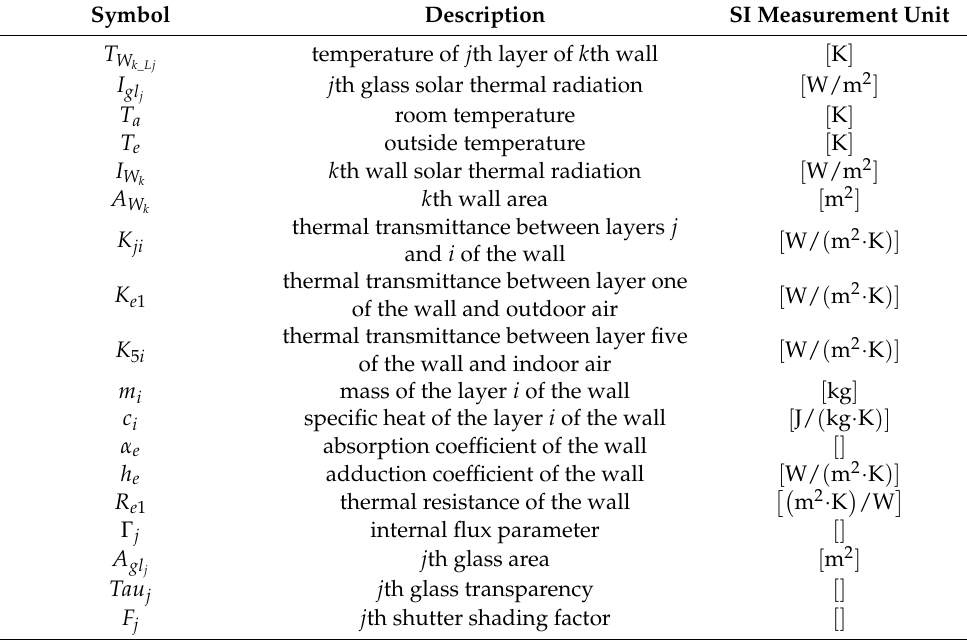
Table 5. Thermal model parameters (Equations (10)–(14)).